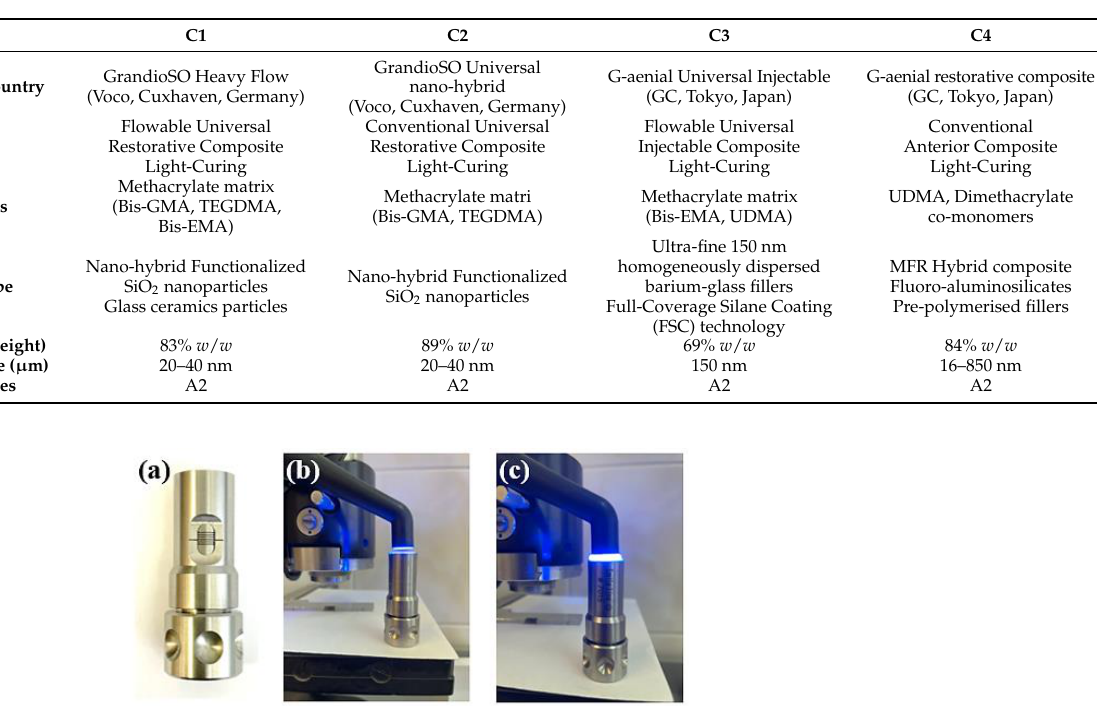
Table 1. Characteristics of the resin-based composite dental filling materials (Flowable vs. Conventional) included in the study.